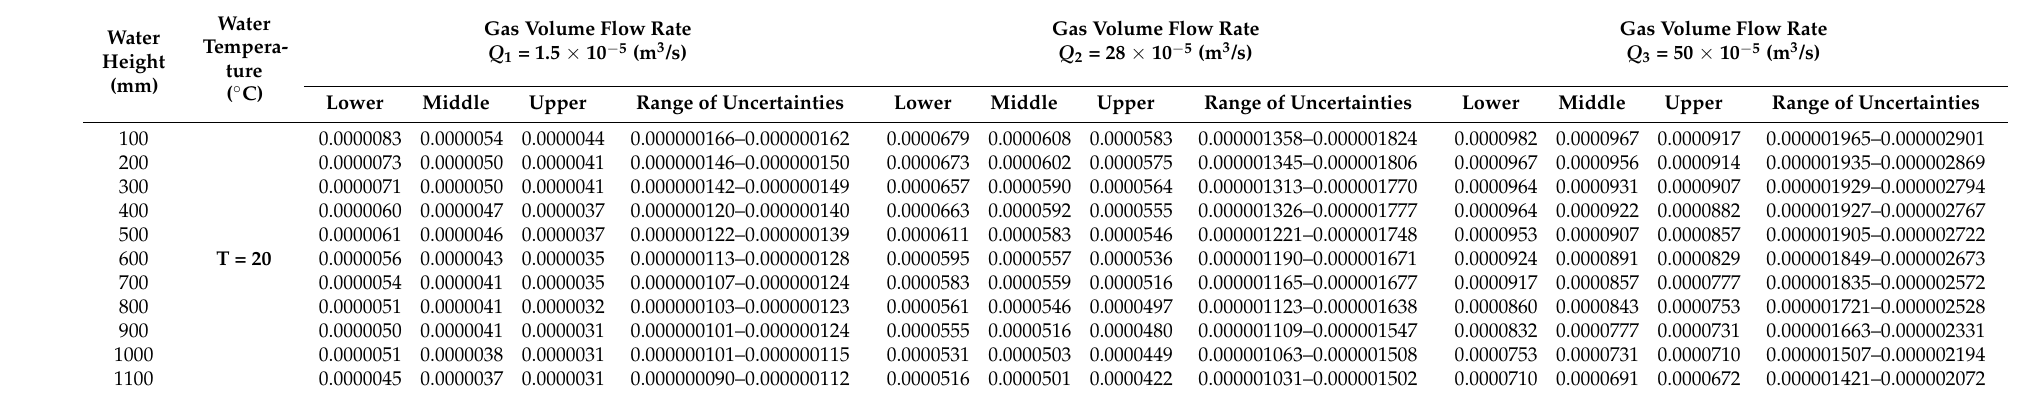
Table 10. Void fraction α as a function of water height for a water temperature of 20 ◦ C and for gas volume flow rates Q 1 –Q 3 .